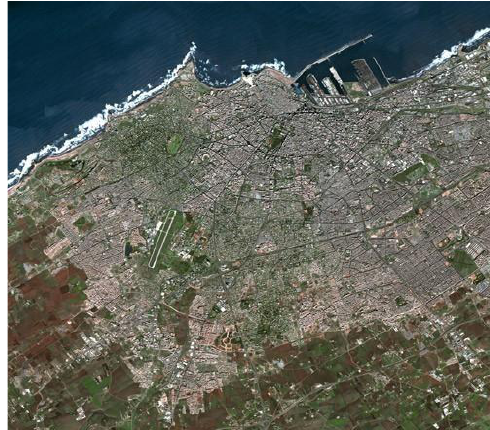
Fig. 2. Satellite Image of Casablanca city.